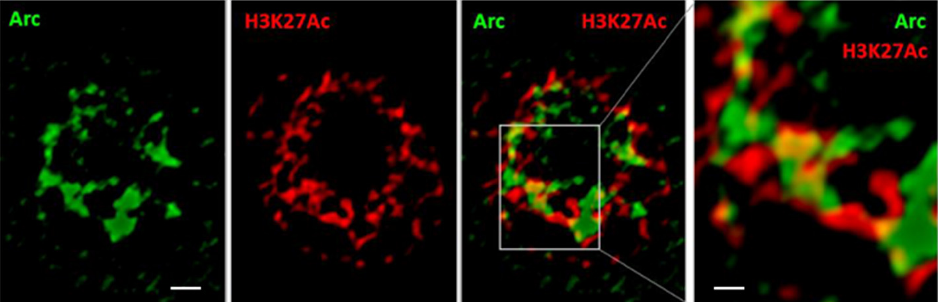
Figure 4. Arc associates with H3K27Ac. Hippocampal neurons were treated with 4BF for 4 h, fixed with methanol and stained for Arc and H3K27Ac, which marks sites containing active enhancers. Z-stacks of images were acquired of neuronal nuclei using a spinning disc confocal microscope (60×, 1.49 NA objective). Resolution was increased using 3D blind deconvolution (AutoQuant). Scale bar is 1 µm. The enlarged section shows the close interaction between Arc and H3K27Ac. Note the elaborate interfaces between Arc (green) and H3K27Ac (red) Scale bar is 500 nm.